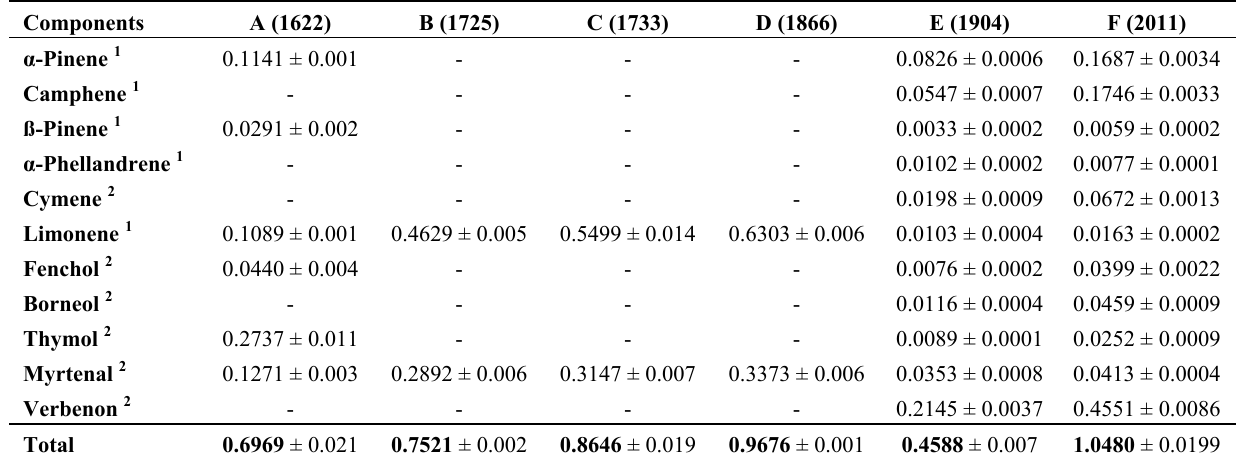
Table 3. Quantities of terpenes in samples of treated wood at the temperature of 120 °C (mg/kg).